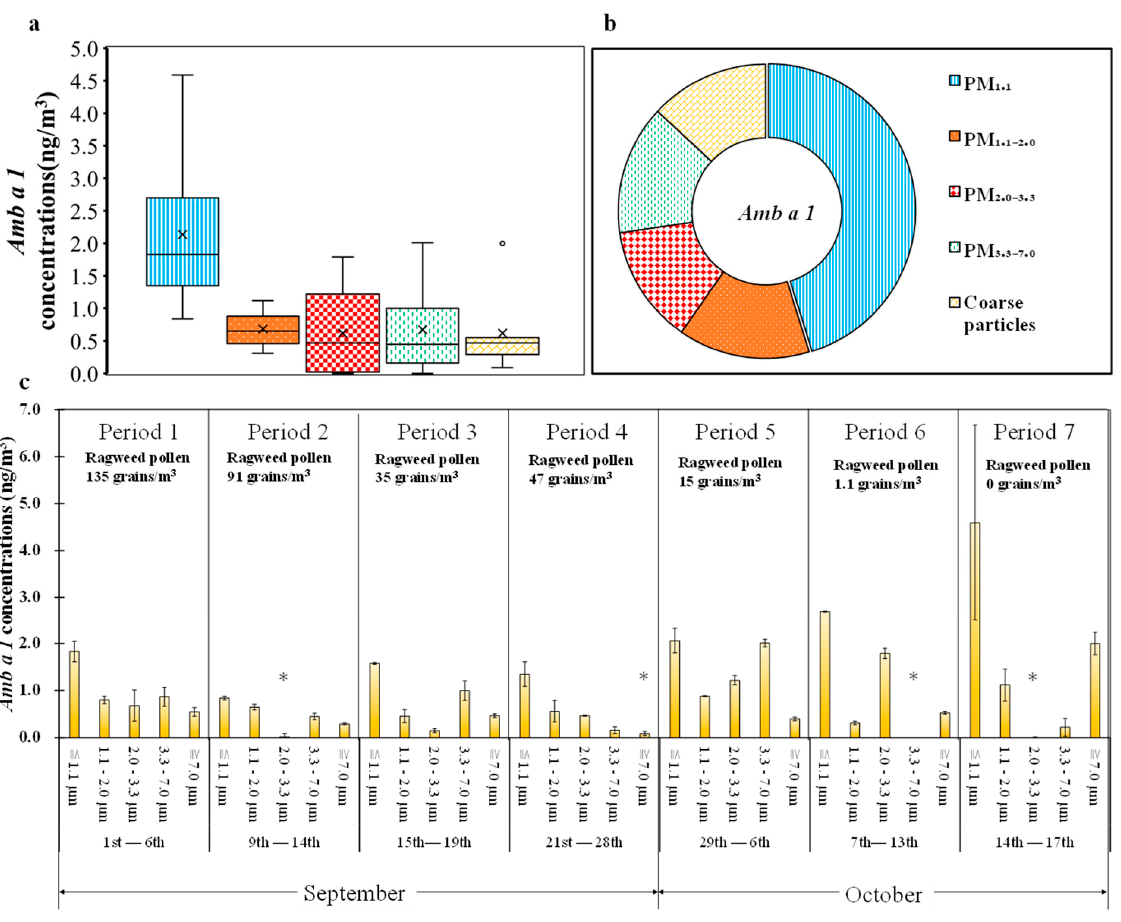
Figure 5. ( a ) The size distribution of Amb a 1 in ambient particles; ( b ) the percentage of Amb a 1 in ambient particles; ( c ) the temporal and size distributions of Amb a 1 in ambient particles during each sampling period. Table 2. The ambient ragweed pollen and Amb a 1 allergen and preceding weather parameters for Saitama,